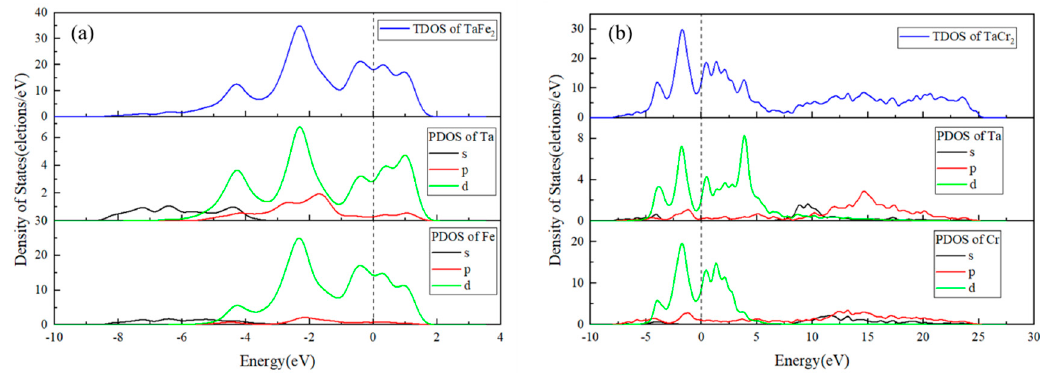
Figure 13. Density of states calculation results: ( a ) TaFe2; ( b ) TaCr2.